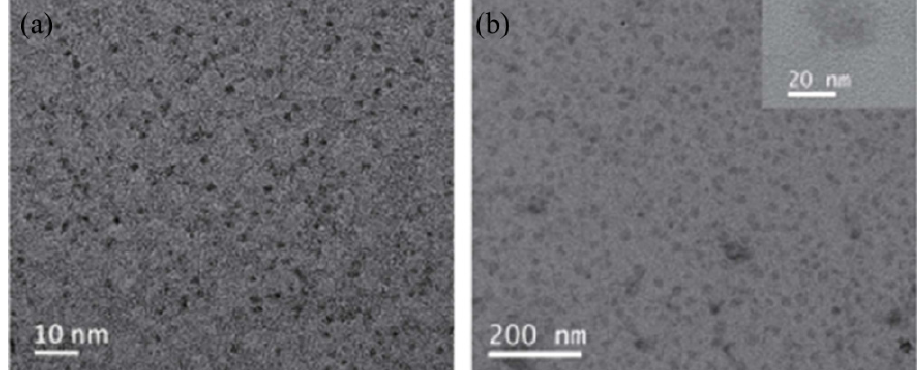
Figure 4. TEM images of RuS 1.7 nanodots ( a ) and PEG-dBSA-RuS 1.7 nanoclusters ( b ) [53].